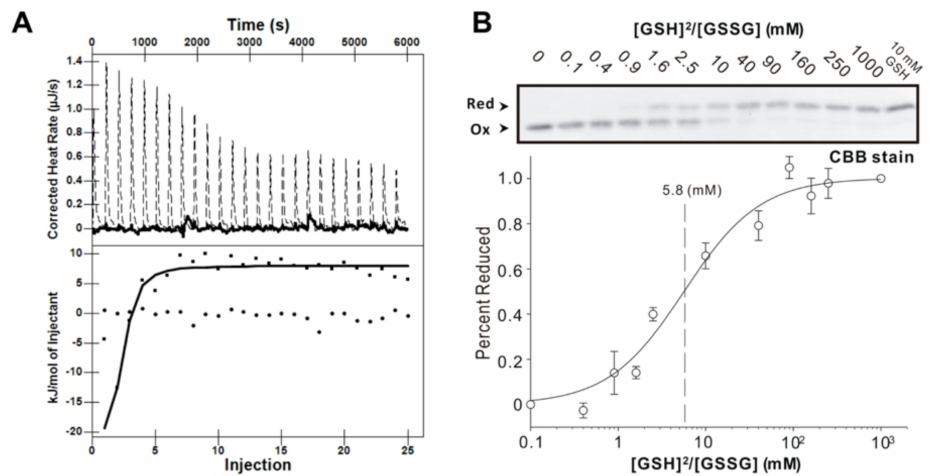
Figure 3. AtAPR1 redox domain possesses glutaredoxin activity. ( A ) Isothermal titration calorimetric thermogram (top) and isotherm (bottom) for the glutathioylation of the AtAPR1 redox domain. The dotted line in the thermogram is the adjusted calorimetric baseline. The solid line in the isotherm was obtained from nonlinear least-squares regression to both the OneSites and the Exchange model (the regression lines from the two algorithms coincide). ( B ) Determination of the equilibrium constant of the AtAPR1 redox domain with glutathione at pH 7.0 and 25 ◦ C. (top) After incubation with di ff erent [GSH] 2 / [GSSG] ratios, the free sulfhydryl groups of the cysteine residues were modified with use of AMS (Bottom). A fraction of the reduced AtAPR1 redox domain was used to measure the redox equilibrium constant of the AtAPR1 redox domain. The apparent equilibrium constant between the AtAPR1 redox domain and glutathione was calculated by nonlinear least-squares fitting of the data in the upper column. Table 2. Thermodynamic parameters for binding of AtAPR1 redox domain to GSH or GSSG. Ligand Kd ( µ M)